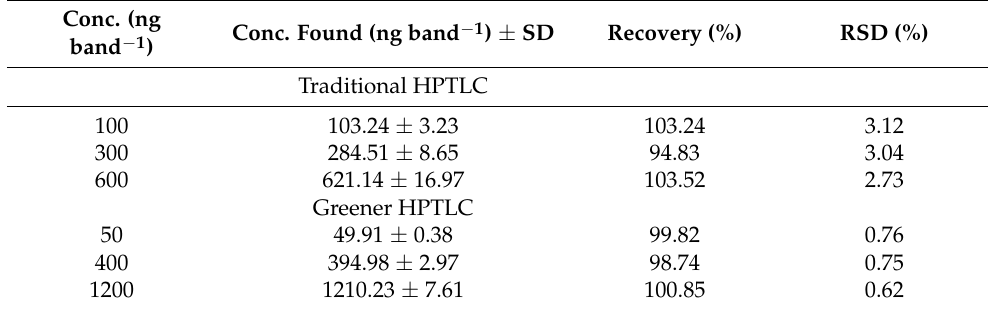
Table 3. Accuracy analysis of VD3 for traditional and greener HPTLC methods (mean ± SD; n = 6).